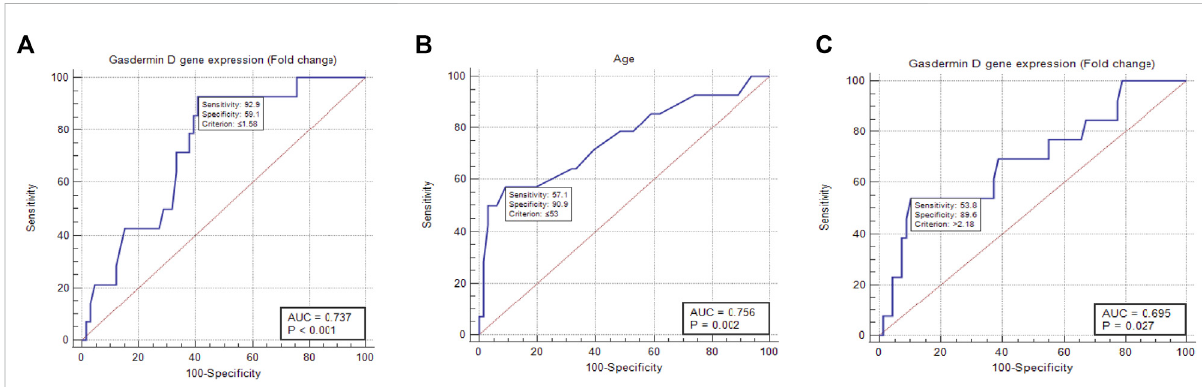
FIGURE 4 ROC curve analysis of gasdermin D gene expression and age showing the cut-off with best sensitivity and sensitivity to predict the local recurrenceanddistantmetastasis. (A) ROCcurveshowingthatgeneexpressionofgasderminD1.58-foldisthecutofftopredictlocalrecurrence. (B) ROC curve showing that age of 53 years is the cutoff to predict local recurrence. (C) ROC curve showing that gene expression of gasdermin D 2.18- fold is the cutoff to predict